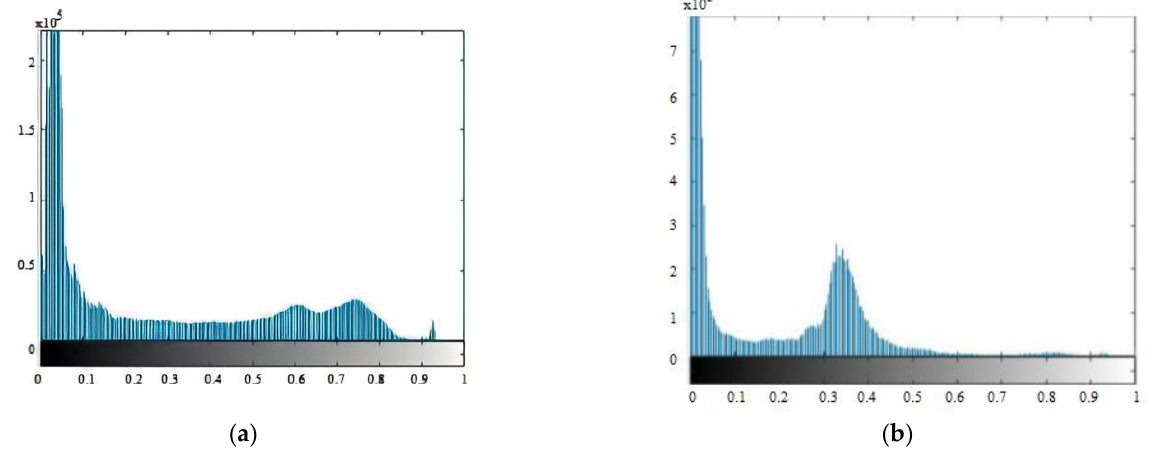
Figure 4. Histograms of mammograms in CC ( a ) and MLO ( b ) views.